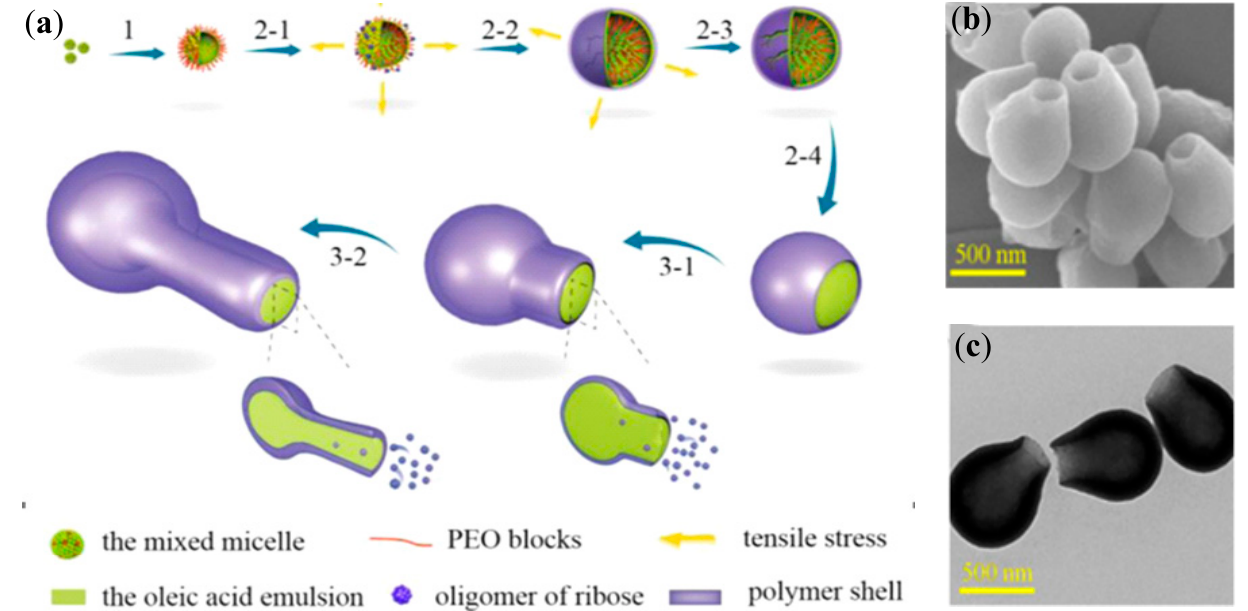
Figure 5. ( a ) Fabrication process of carbon nanobottle motor. ( b ) SEM image and ( c ) TEM image of Carbon nanobottles. The scale bar is 500 nm. Reprinted with permission from Ref. [42]. Copyright 2017, copyright American Chemical Society.